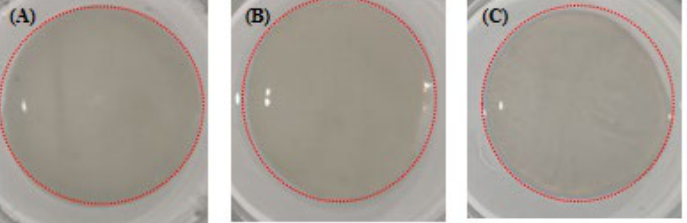
Figure 11. Skin collagen (SC) gels (inside the red circle) of C. idella formed under different salinity and pH: ( A ) gel formed at NaCl concentration of 280 mM and pH 7; ( B ) gel formed at NaCl concentration of 140 mM and pH 8; ( C ) gel formed at NaCl concentration of 280 mM and pH 8.